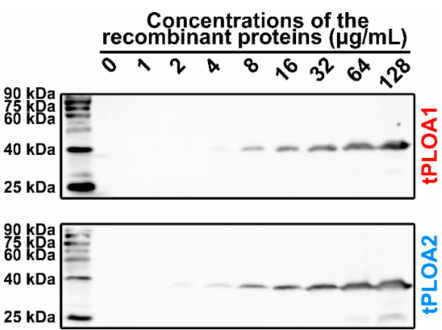
Figure 3. Results of cell membrane binding assays. Both tPLOA1 and tPLOA2 could bind to sRBCM. The results indicated that the D4 structures in tPLOA1 and tPLOA2 keep the cholosterol-binding function. Thus, in the following experiment, sheep red blood cell membrane (sRBCM) could be used as an adjuvant for preparing vaccines. This assay was performed for at least three times.